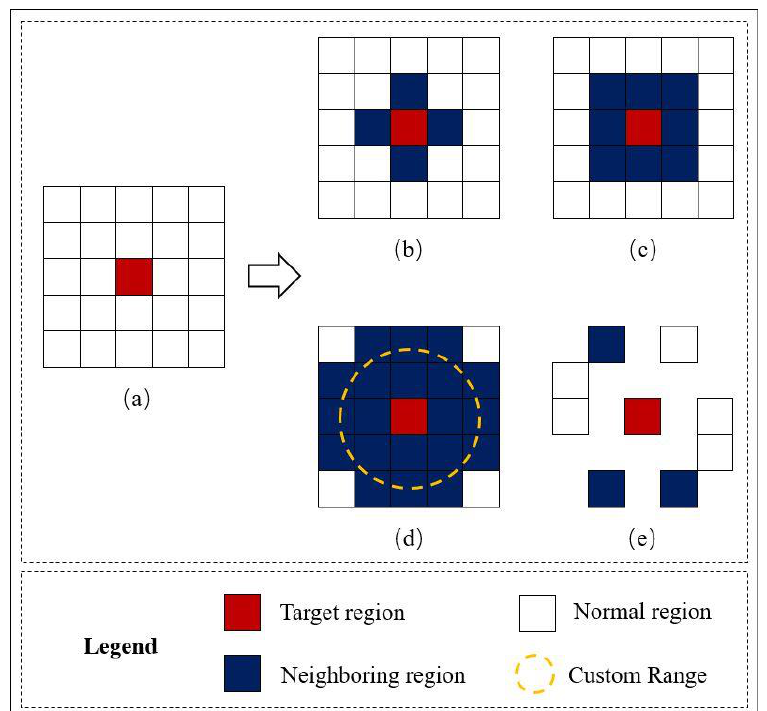
Figure 5. Regional adjacency relationships. ( a ) Vector areas with the target region; ( b ) adjacent edge relationship; ( c ) adjacent edge and corner relationship; ( d ) customized adjacent range relationship; and ( e ) logical adjacent relationship.